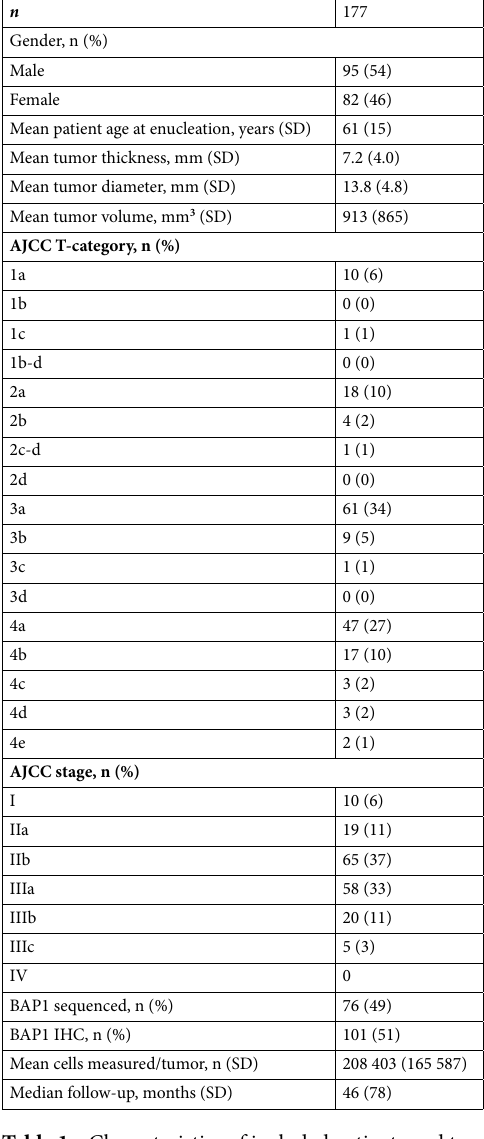
Table 1. Characteristics of included patients and